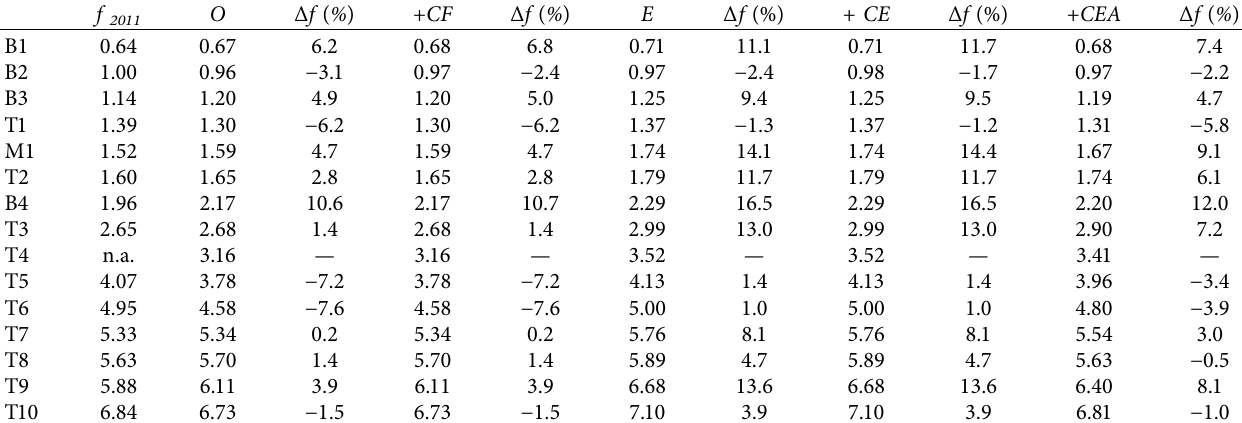
Table 4: Comparison of the numerical and experimental frequencies for different modelling choices.